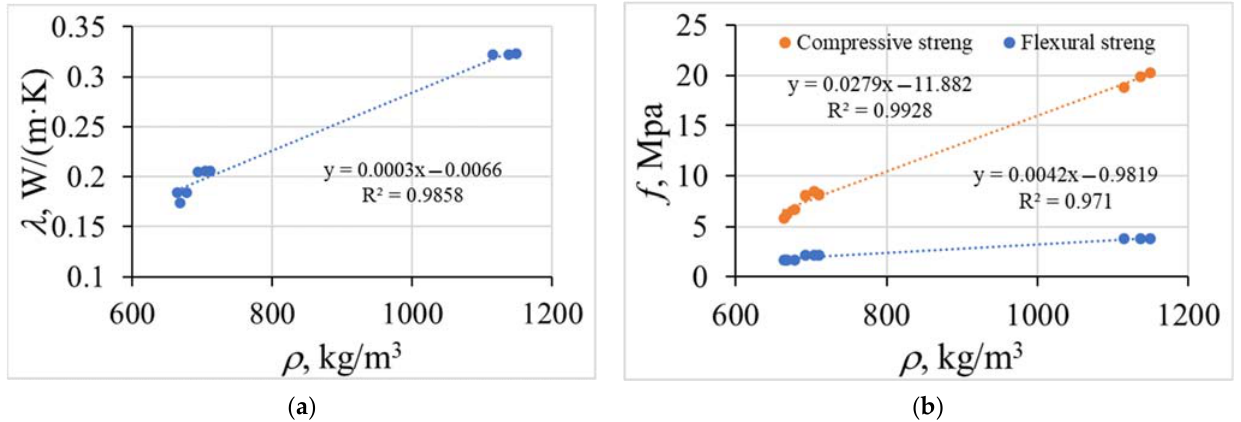
Figure 3. The relation between densities ρ of the dry samples with: ( a ) thermal conductivity coeffi- cient λ ; ( b ) mechanical strength f . λ ; ( b ) mechanical strength f .